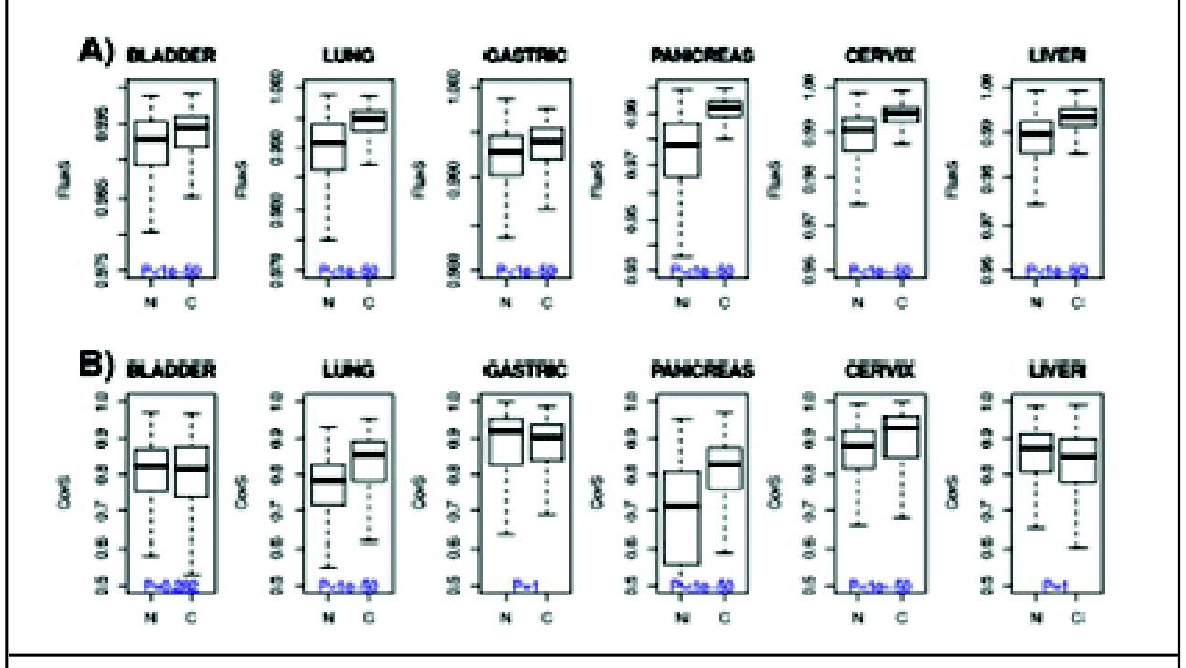
Figure 3A: Distributions of flux entropy (FluxS) between normal (N) and cancer (C) samples; and